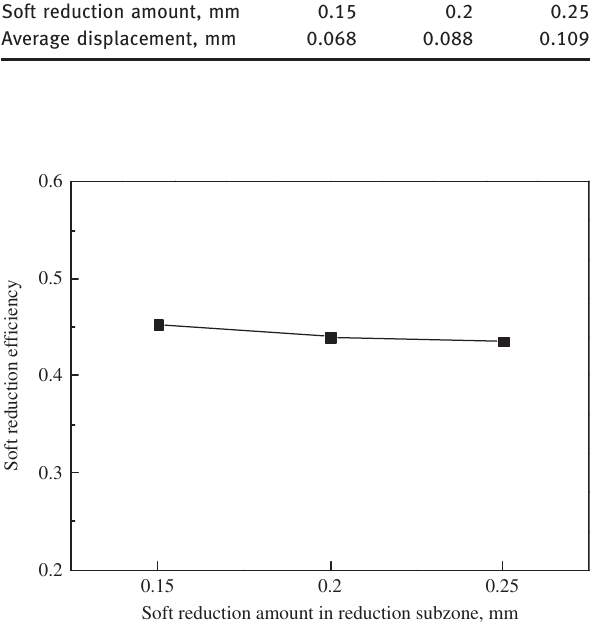
Figure 10: Relationship between the soft reduction efficiency and soft reduction amount.